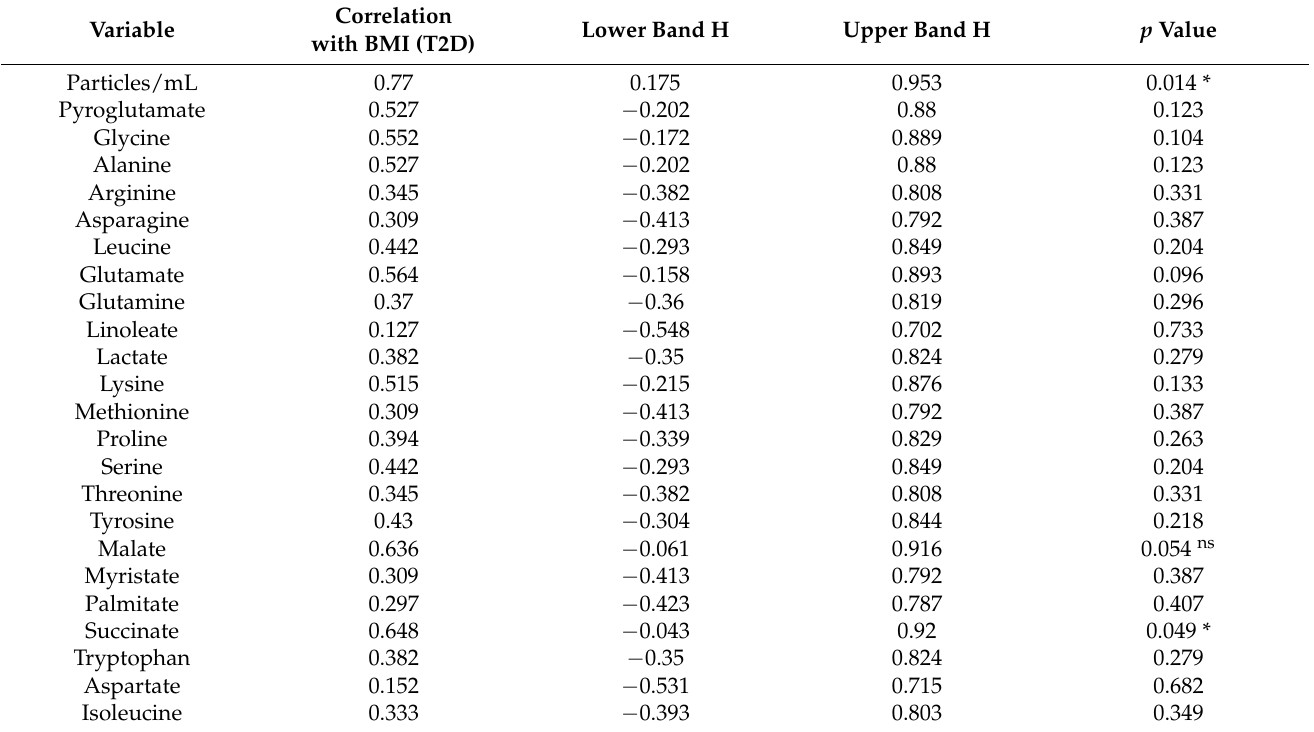
Table 7. Spearman’s rank correlation between BMI and the metabolite levels in the EVs isolated from T2D participants upon heat exposure. * p < 0.05 is significant. ns. not